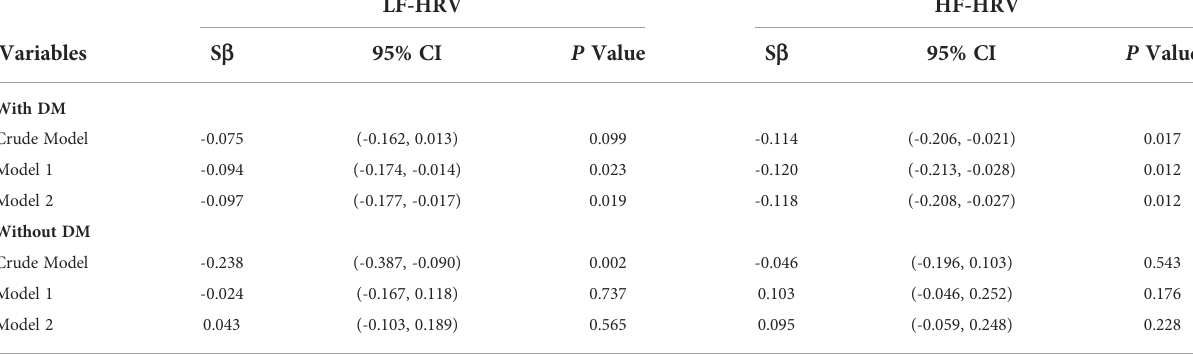
TABLE 2 Multiple linear regression analysis for relationship between blood hemoglobinA1c and